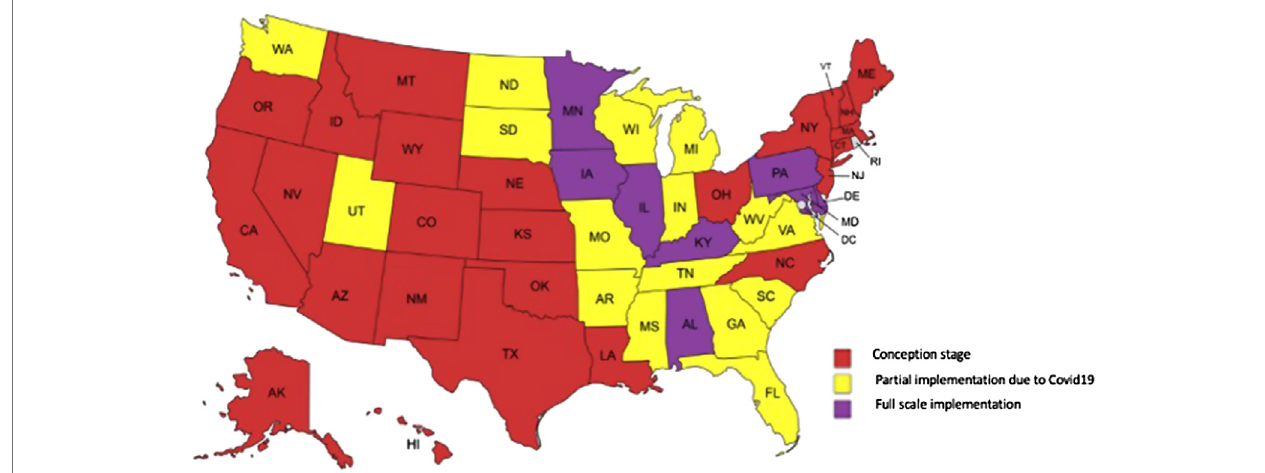
FIGURE 4 | Map depicting adoption of E-ticketing by states